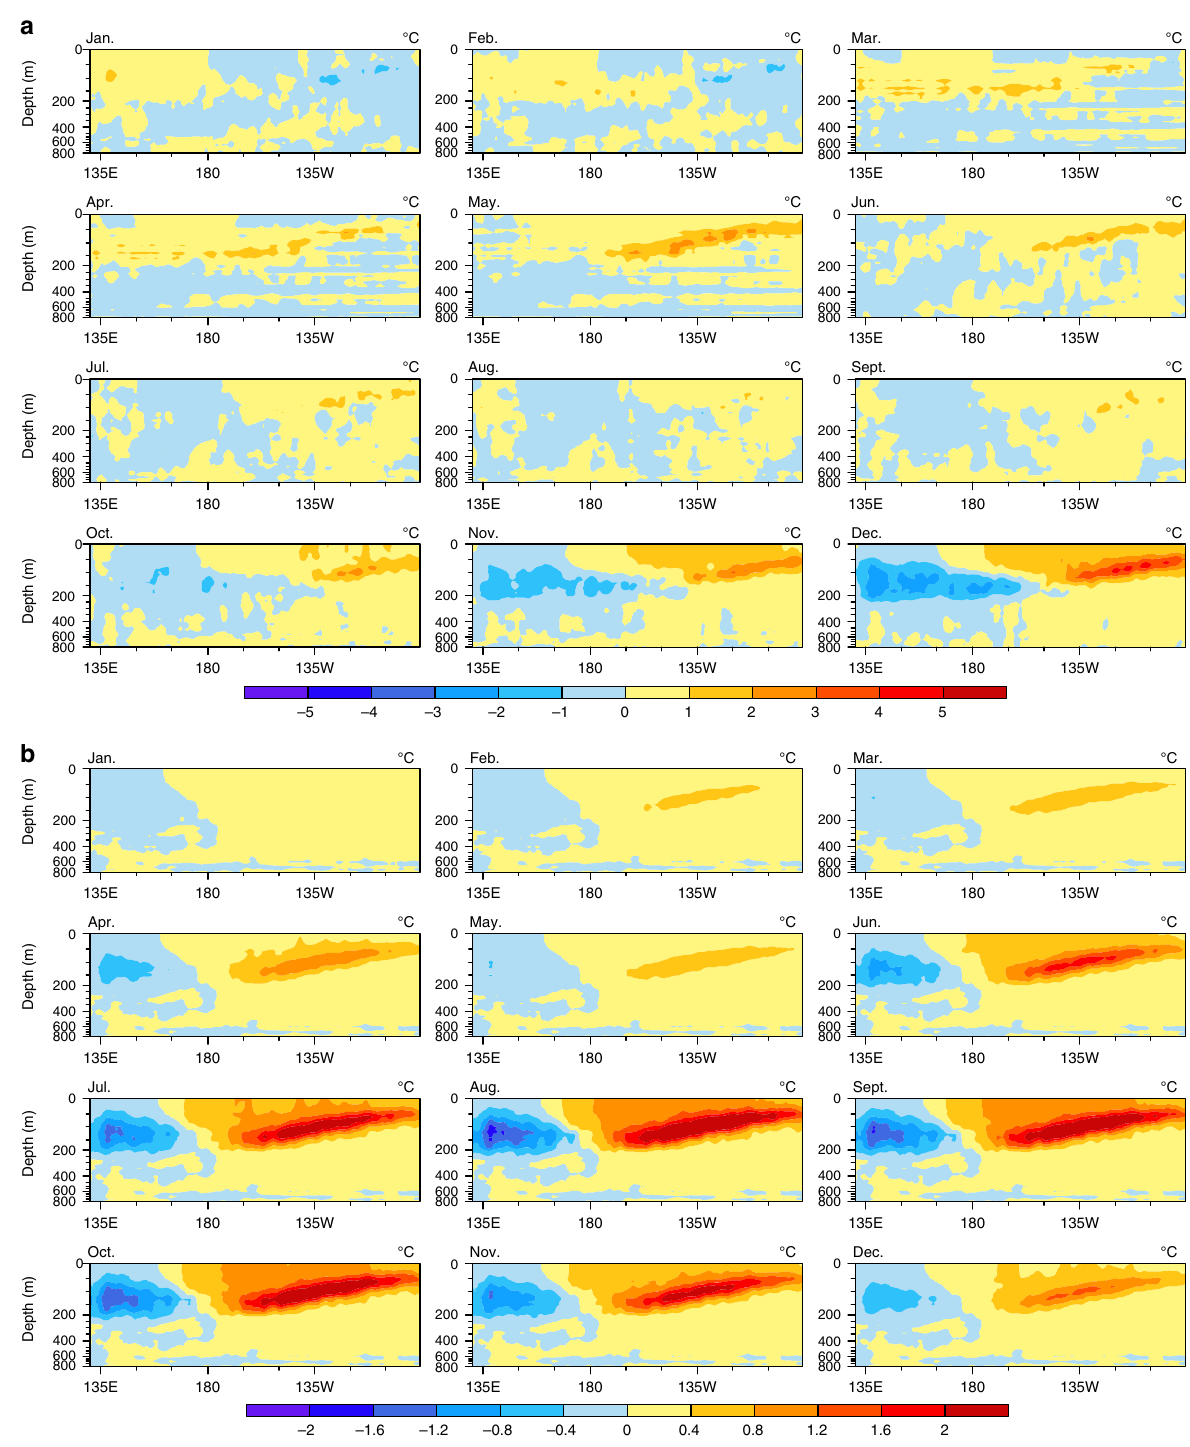
Fig. 5 Composite of the depth – zonal distribution of monthly equatorial potential temperature anomalies averaged between 5°S − 5°N (shading; °C) during the El Niño developing years (2004 − 2016). a Distribution of monthly equatorial potential temperature anomalies after removing the simultaneous WNP ACE. b As in a , but relating to the simultaneous WNP ACE. An El Niño developing year is de fi ned when the above-moderate El Niño events